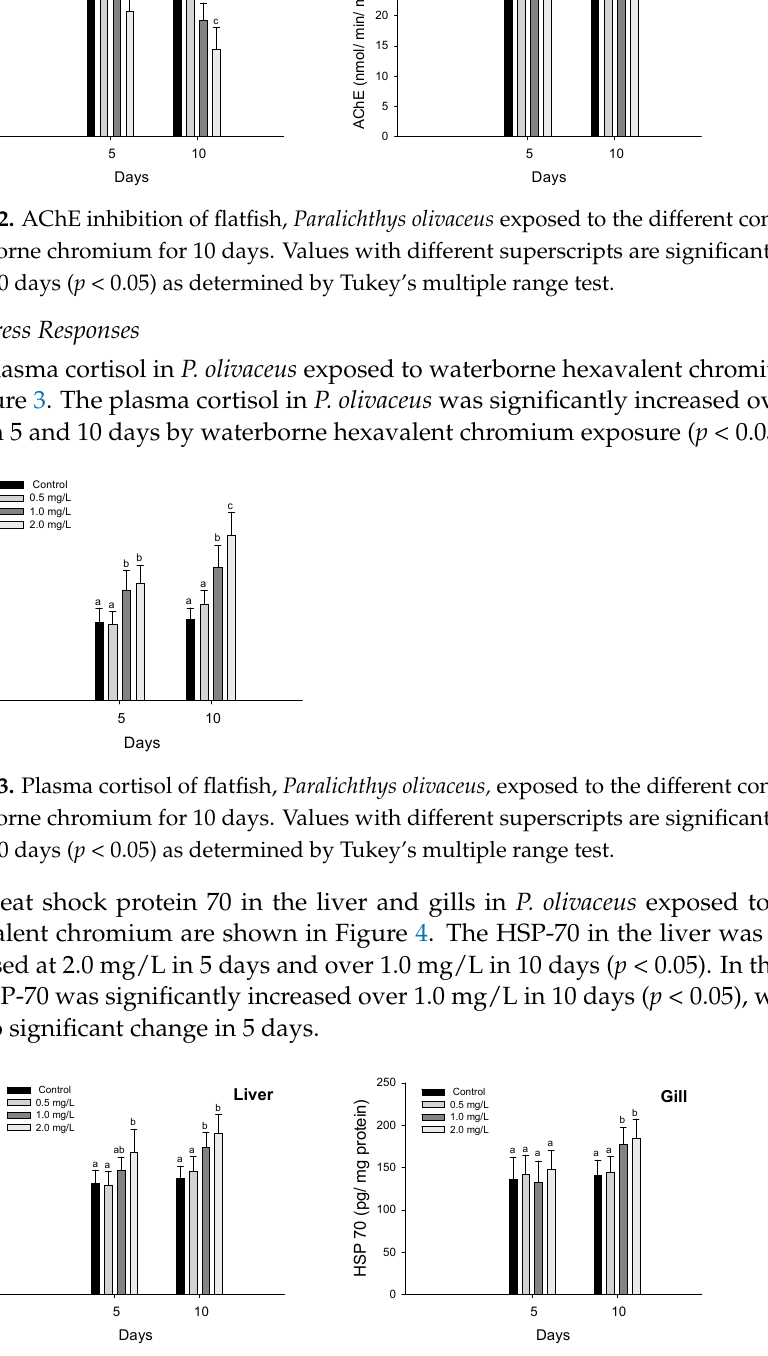
Figure 2. AChE inhibition of flatfish, Paralichthys olivaceus exposed to the different concentrations of waterborne chromium for 10 days. Values with different superscripts are significantly different in 5 and 10 days ( p < 0.05) as determined by Tukey’s multiple range test.